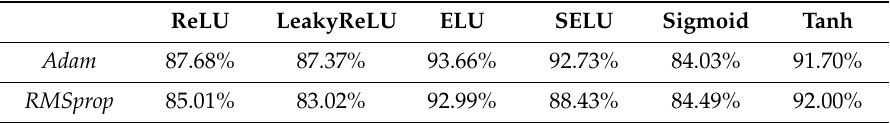
Table 3. The AUC results of both optimizers for the di ff erent activation functions.